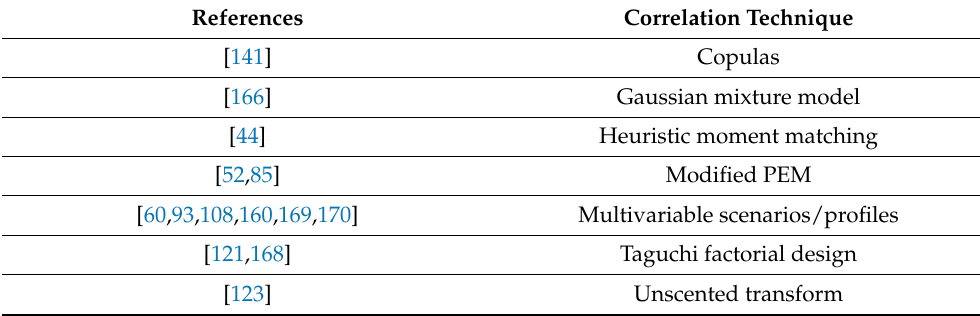
Table 13. Methods employed in the articles to integrate correlation between variables.